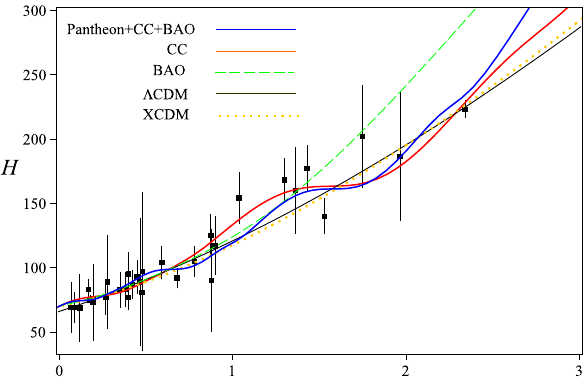
Fig. 6 The plot of parameters H for the best-fitted parameters and initial conditions in chameleon model for different data